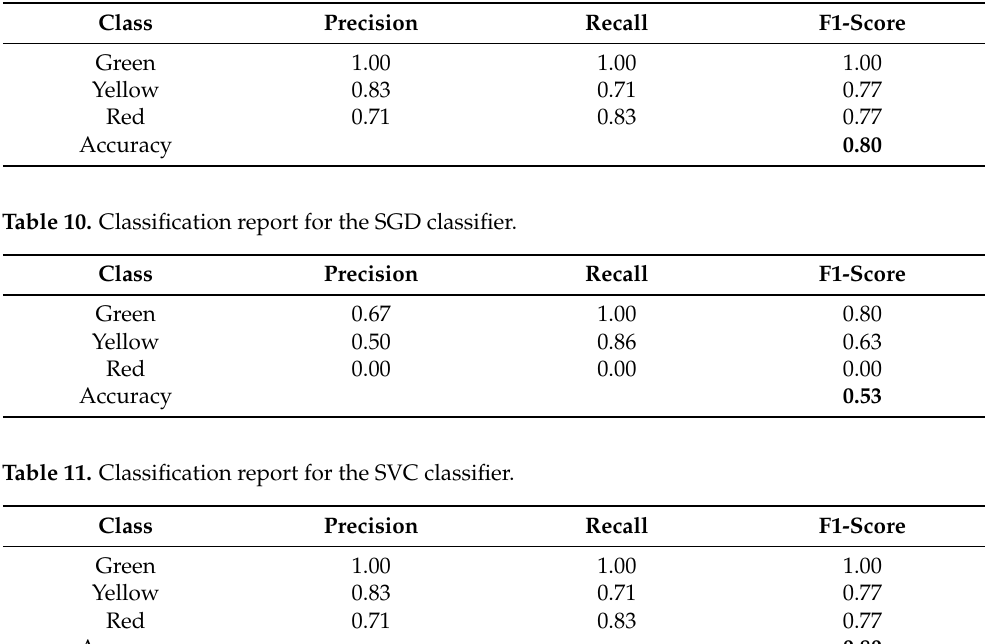
Table 9. Classification report for the K-NN classifier.